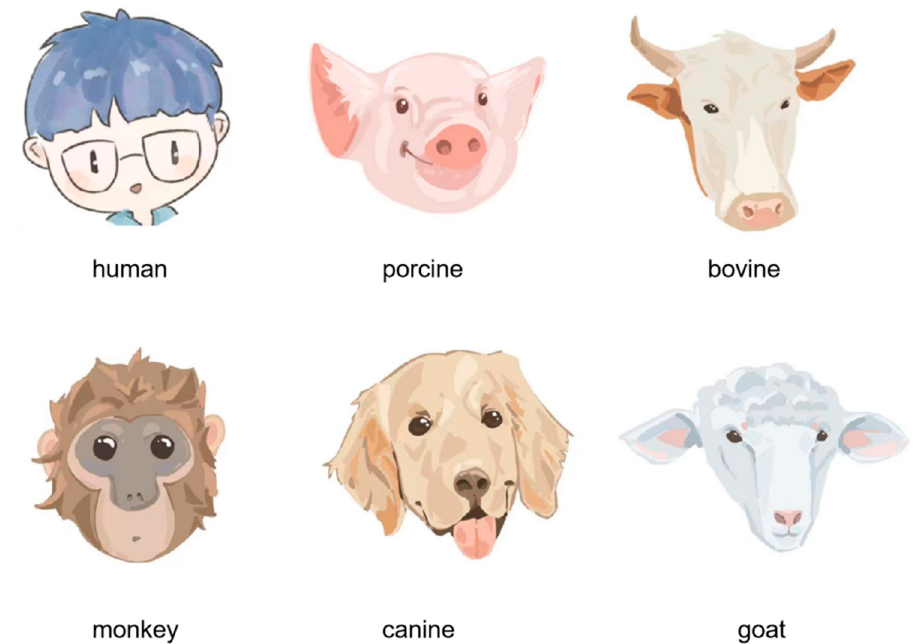
Figure 2. Animal origins of treated dentin matrixes.